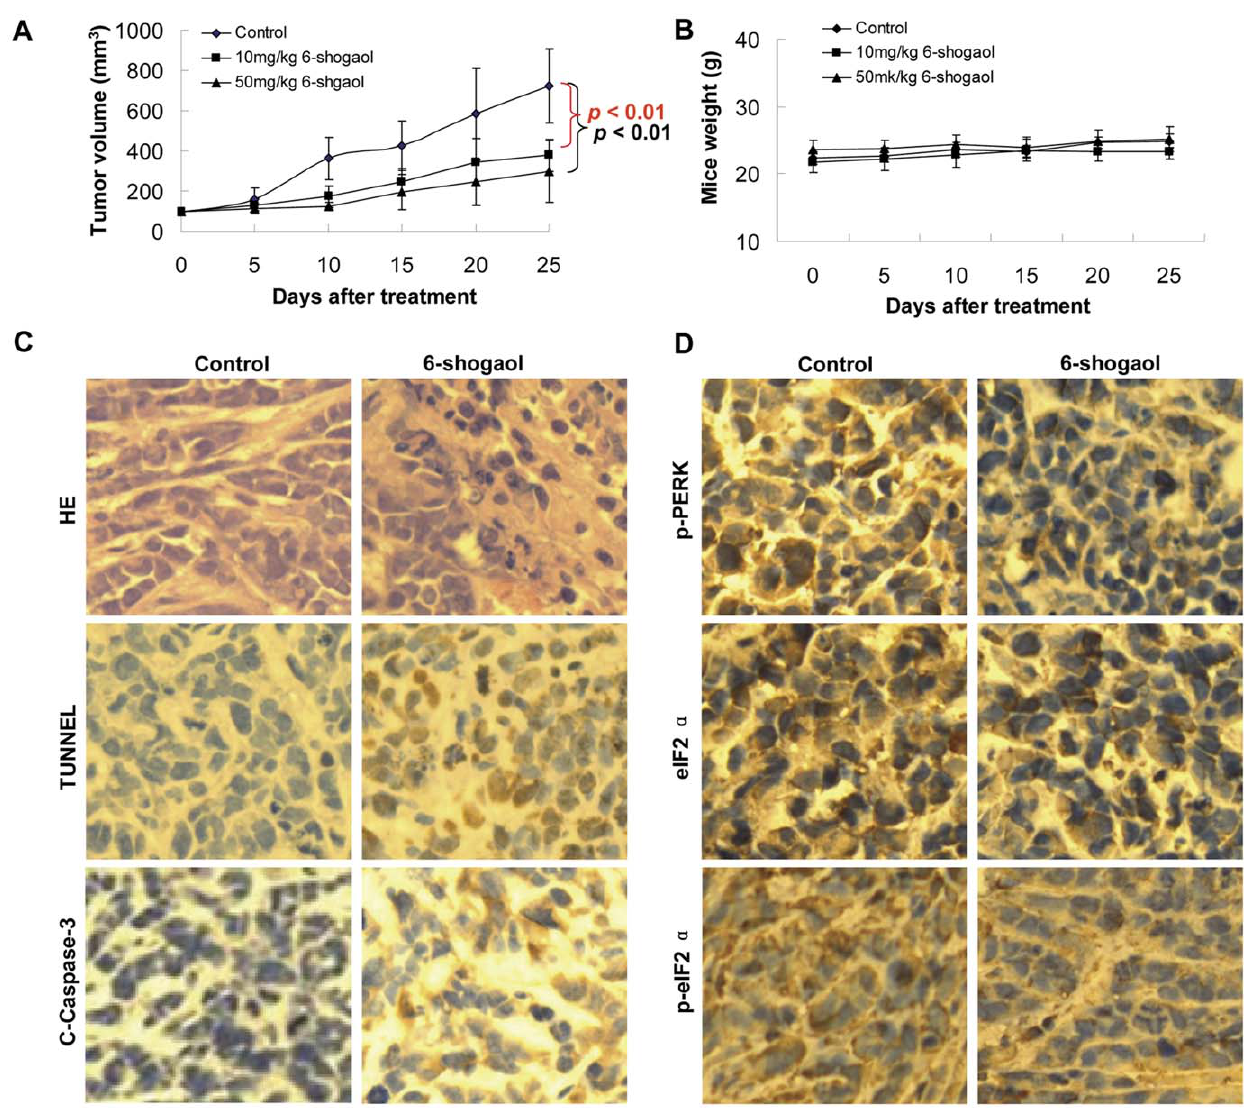
Figure 6. Invivo antitumor effects of 6-shogaol in SMMC-7721 xenografts. SCID mice were inoculated with SMMC-7721 cells (3 6 10 6 cells/ mouse, s.c.) and randomly divided into three groups (8/group) treated with 6-shogaol (10 mg/kg and 50 mg/kg, i.p., daily) or vehicle control solvent. (A) Average tumor volume in vehicle control mice and mice treated with 10 mg/kg and 50 mg/kg 6-shogaol. ** P , 0.01. (B) Body weight changes of mice during the 28 days of study. (C) Representative photographs of biopsy samples from mice treated with 6-shogaol (50 mg/kg) and vehicle control. Original magnification 6 400. (D) Expression of p-PERK, eIF2 a , and p-eIF2 a in tumor tissues of SMMC-7721 xenograft mouse model treated with 6-shogaol (50 mg/kg) and vehicle